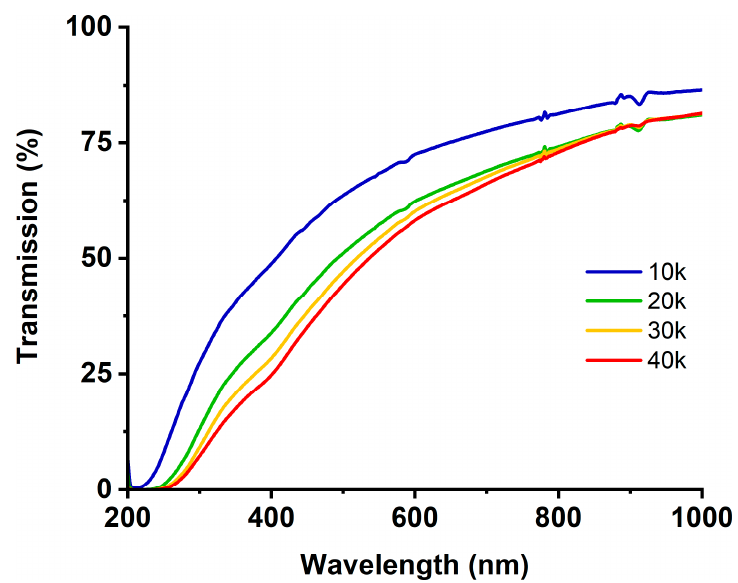
Figure 2. Transmission spectra obtained from pulsed laser ablation in liquid (PLAL) synthesis of nickel nanoparticles for 10–40 thousand laser pulses.